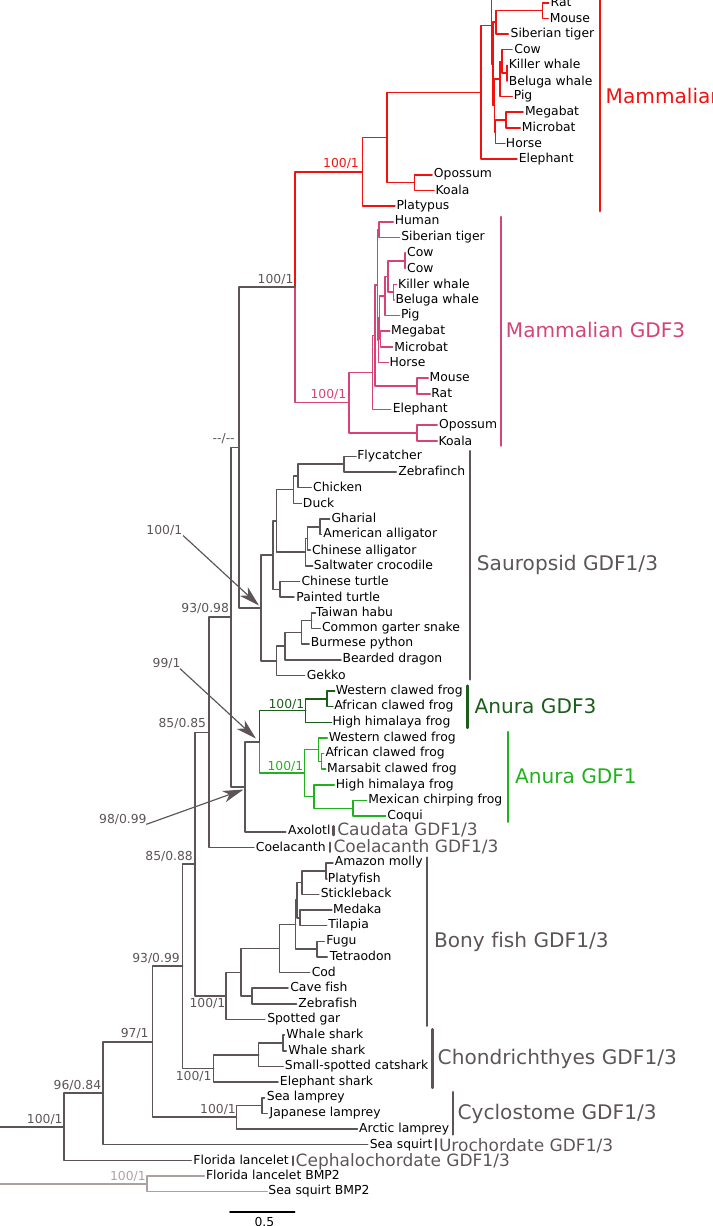
Figure 1. Maximum likelihood tree depicting evolutionary relationships among the GDF1 and GDF3 genes of chordates. Numbers on the nodes represent maximum likelihood ultrafast bootstrap and Bayesian posterior probability support values. The arrows indicate the support value in nodes in which space is limited to write it. BMP2 sequences from urochordates ( Ciona intestinalis ) and cephalochordates ( Branchiostoma floridae ) were used as